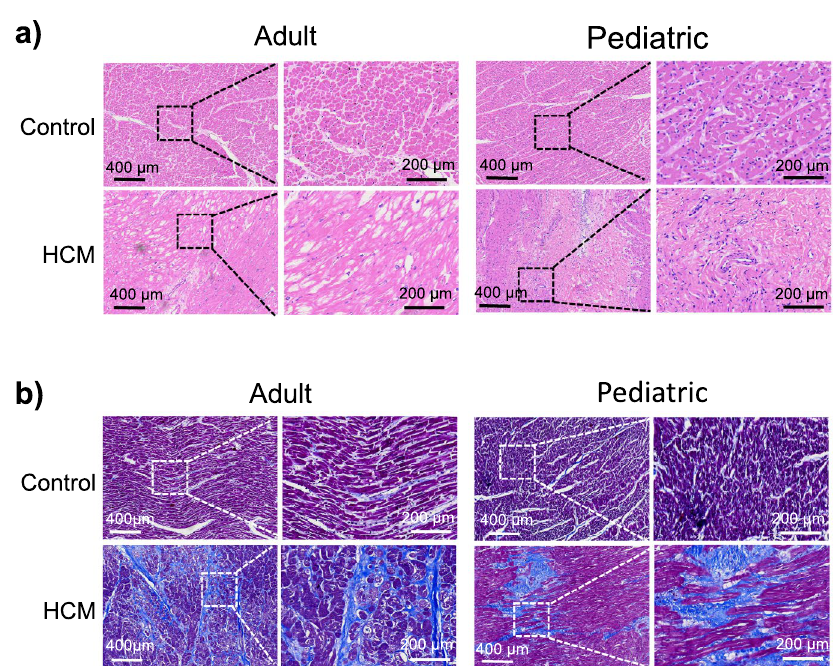
Figure 1. Morphological examinations of myocardial tissue from patients with HOCM. ( a ) Representative images of haematoxylin and eosin (H&E) staining of ventricular septal myocardial tissue from adult HOCM and pediatric HOCM patients, compared to their controls. Scale bars, 400 μm and 200 μm (enlarged views of boxed areas). ( b ) Representative images of Masson’s Trichrome staining of heart sections from adult HOCM and pediatric HOCM patients, compared to their controls. Scale bars, 400 μm and 200 μm (enlarged views of boxed